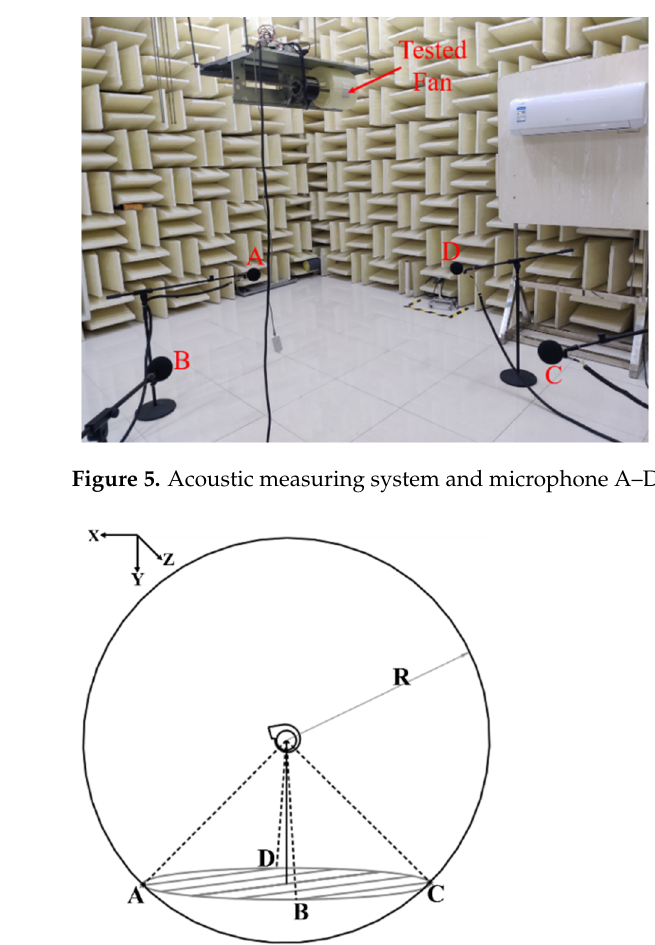
Figure 6. Spherical envelope method and corresponding test points of microphone A–D.